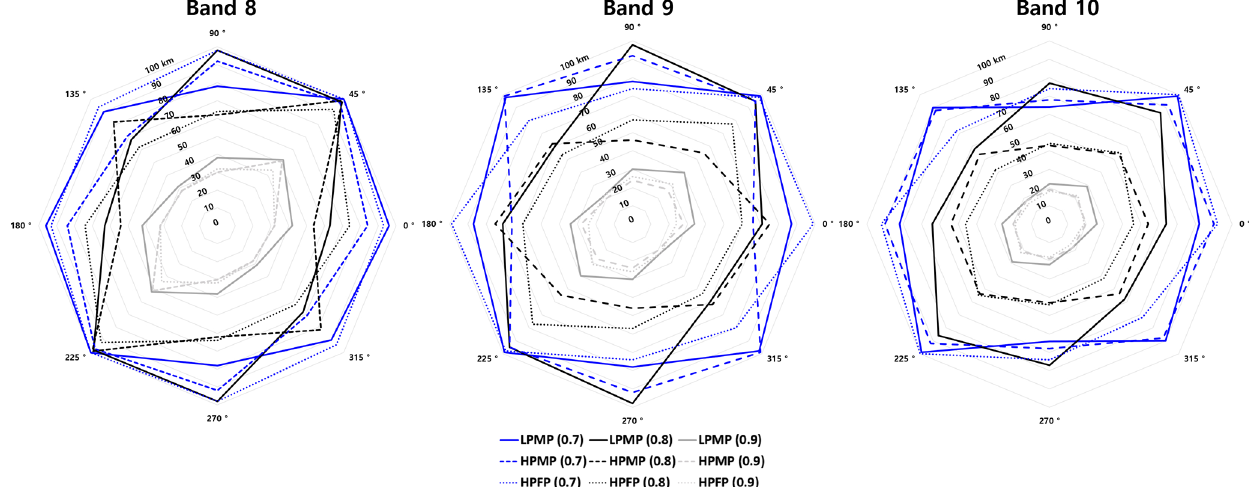
Figure 8. A radar chart representing the directional separation distance (in km) of brightness temperature of the AHI water vapor band 8, 9, and 10 at the mode in the histogram of case numbers for LPMP (solid), HPMP (dashed), and HPFP (dotted). The colors indicate autocorre- lation coefficients of 0.7 (blue), 0.8 (black), and 0.9 (grey),